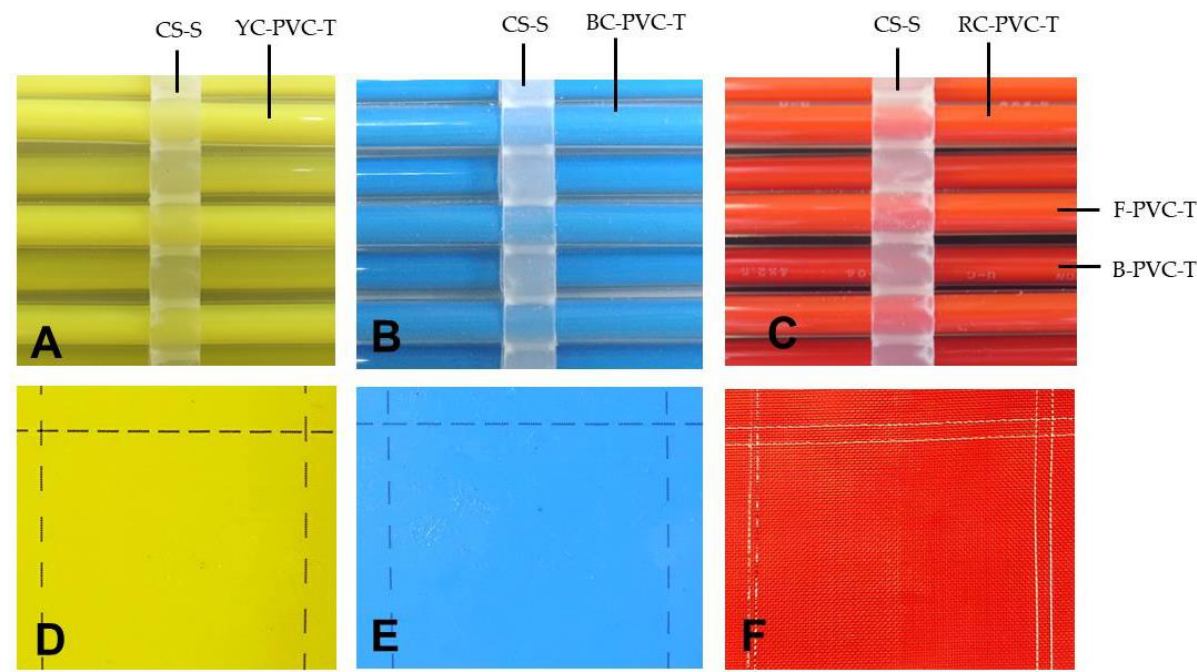
Figure 6. Comparison of hue-/value-/chroma-based coloration among transparent PVC tubes con- taining ( A ) yellow-, ( B ) blue-, and ( C ) red-colored water, and commercially available ( D ) yellow and ( E ) blue sticky traps, or ( F ) a red insect-proof net. Abbreviations: CS-S, comb-shaped